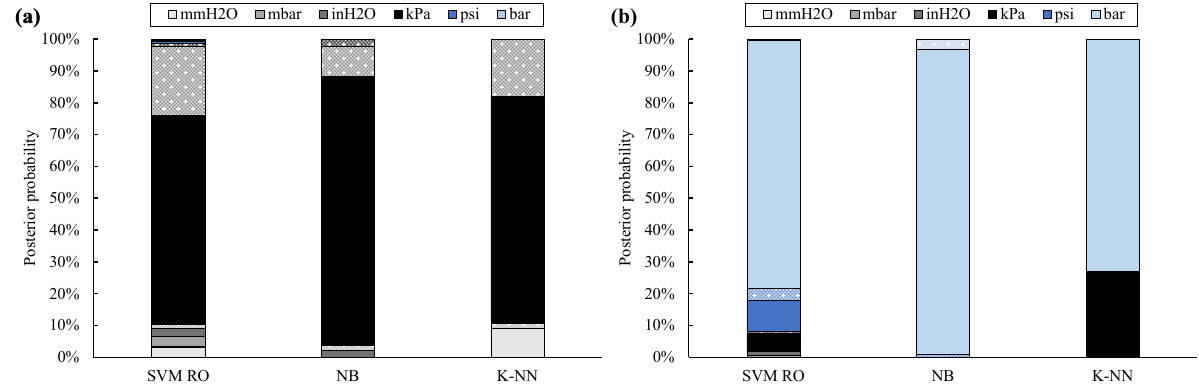
Figure 6. Posterior probability for twelve UOMs: training with 10% of non-filtered data (full bar: absolute UOMs, dotted bar: gauge UOMs; kPa absolute sites ( a ), bar absolute site ( b )).